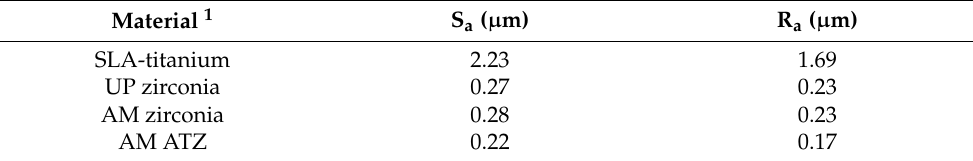
Table 1. Results of the surface roughness analysis: arithmetic mean height (S a ) and arithmetic mean roughness (R a ).